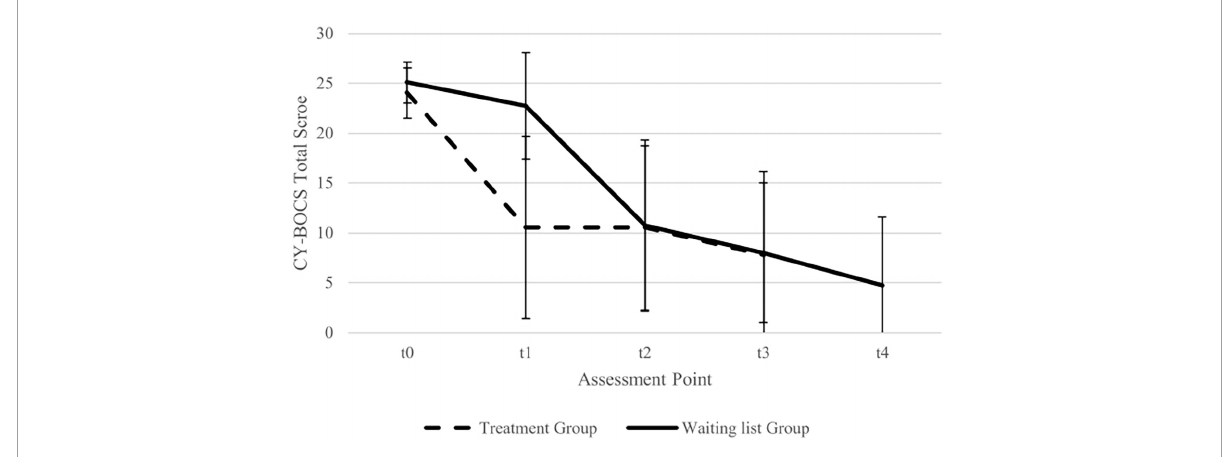
FIGURE2 Imputed data for total Children’s Yale Brown Obsessive Compulsive Scale (CY-BOCS) mean scores (with standard deviation) for treatment group and waiting list group. Assessment points treatment group: t0 = baseline, t1 = post-treatment, t2 = 16 weeks Follow Up, t3 = 32 weeks follow-up. Assessment points waiting list group: t0 = baseline, t1 = pre treatment, t2 = post-treatment, t3 = 16 weeks follow-up, t4 = 32 weeks follow